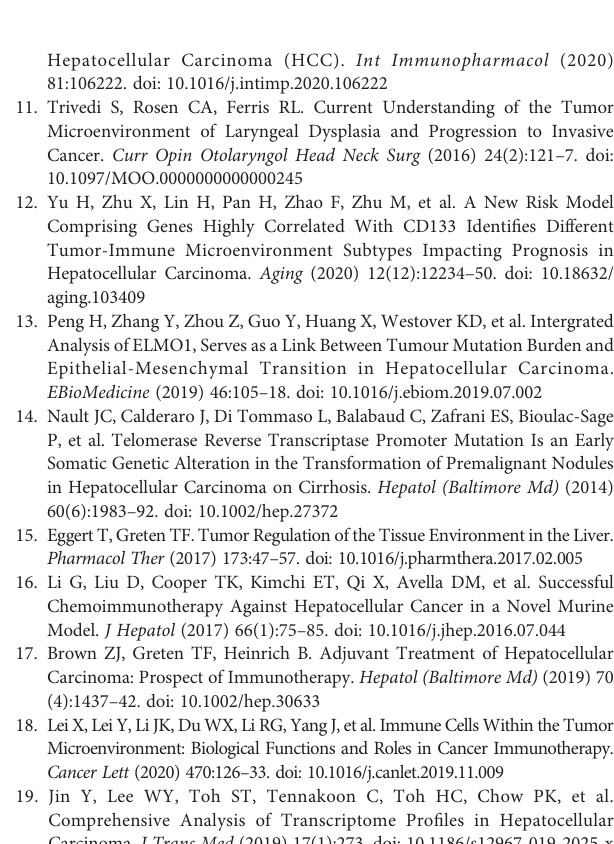
Supplementary Figure 2 | Histopathological changes in the livers from DEN induced rats and control rat. (A) , liver tissue from control rat; H&E staining revealed normalcellular architecture where hepatocytes are arranged in cellplates separated by sinusoids rat, (B) , Liver tissue of eHCC rat; H&E staining demonstrated eosinophilic focus of cellular alteration (left) including small cell change (middle), and clear cell focus of cellular alteration (right). Supplementary Table 1 | A total genes between tumor and normal with available clinical information. Supplementary Table 2 | Signi fi cantly expressed genes. Supplementary Table 3 | Overview of 53 differently expressed genes detail. Supplementary Table 4 | Enrichment of DEGs in different stage HCC patients. Supplementary Table 5 | Fisher ’ s test of the cluster